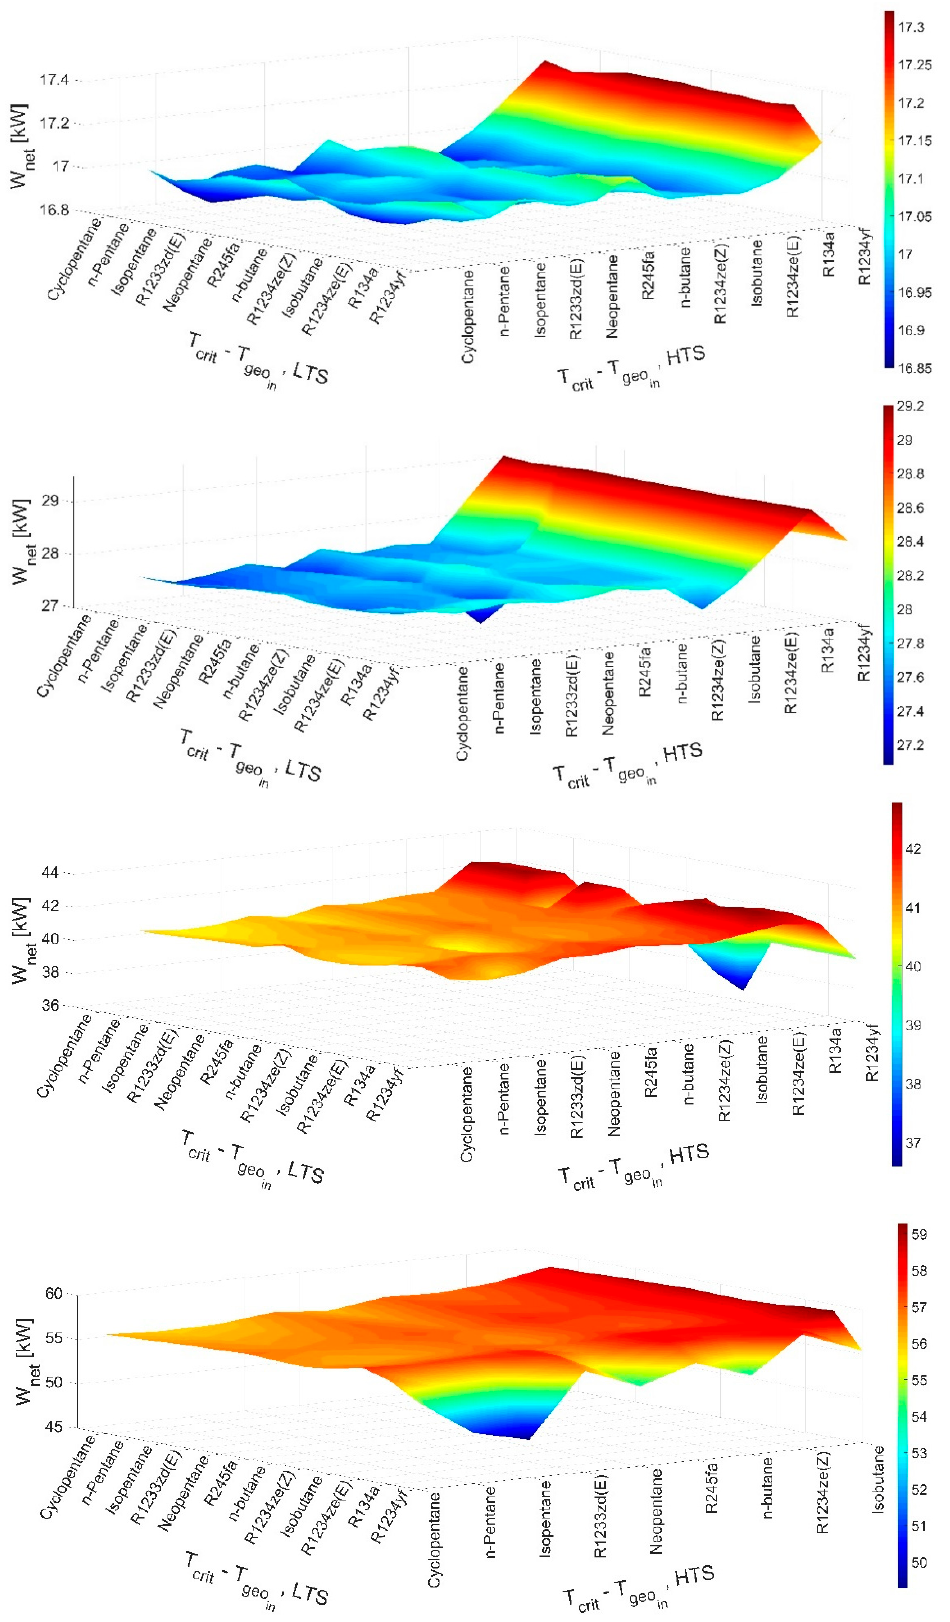
Figure 6. Net power output of the DS HTSIHE ORC configuration, as a function of the working fluids in HTS and the LTS, for the geothermal heat source characteristic temperatures.